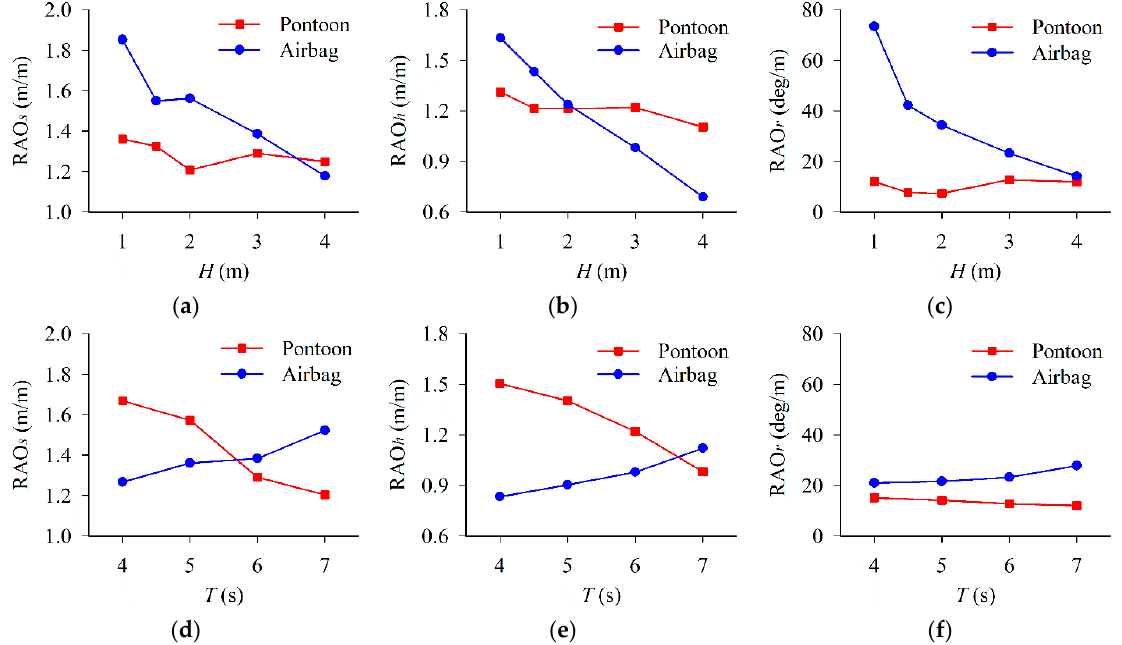
Figure 17. Comparison of the response amplitude operators of the double-row floating breakwater under different wave parameters: ( a ) Sway motion RAO s , H = 1–4 m and T = 6 s; ( b ) Heave motion RAO h , H = 1–4 m and T = 6 s; ( c ) Roll motion RAO r , H = 1–4 m, T = 6 s; ( d ) Sway motion RAO s , H = 3 m, T = 4–7 s; ( e ) Heave motion RAO h , H = 3 m, T = 4–7 s; ( f ) Roll motion RAO r , H = 3 m, T = 4–7 s.